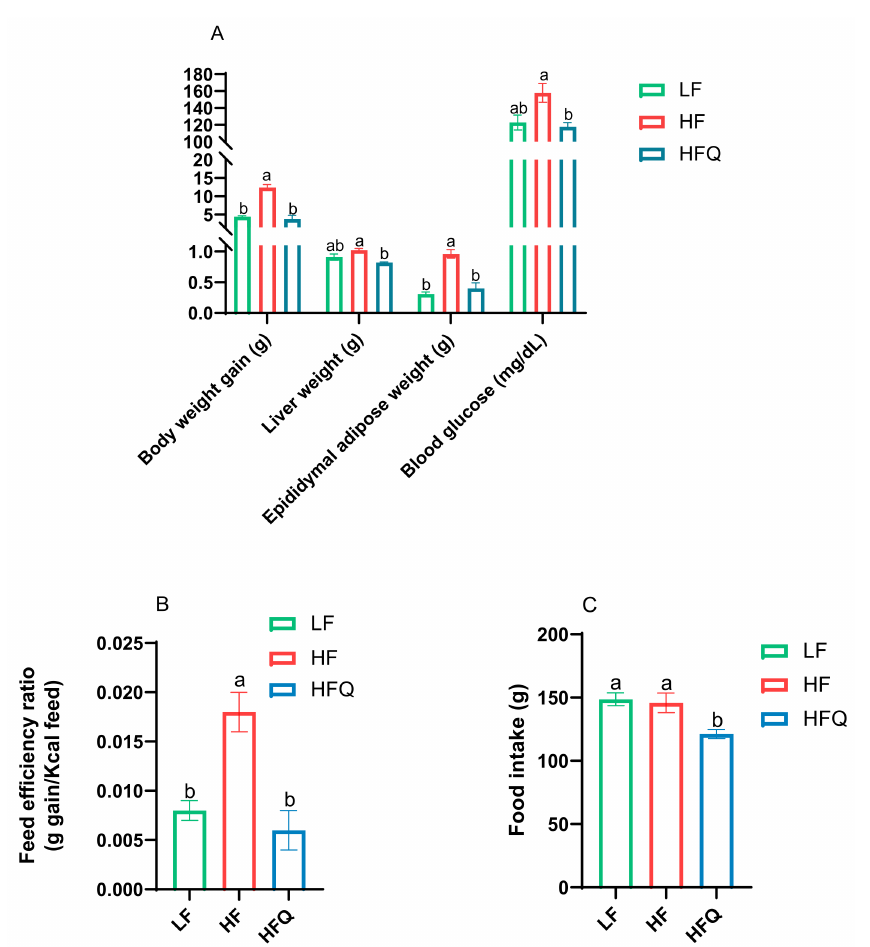
Figure 1. ( A ). Anthropometrics in mice fed HF, HFQ, and LF diets for 6 weeks. HF: high-fat control diet (46% kcal from fat, 16.5% kcal from protein, and 37.5% kcal from carbohydrate); HFQ: 0.05% quercetin in high-fat diet; LF: low-fat control diet (16% kcal from fat, 20% kcal from protein, and 64% kcal from carbohydrate) ( B ). Feed efficiency ratio of mice fed different diets. ( C ). Food intake of mice fed different diets. Values are means ± SEMs, n = 8/group. Bars with different letters were significantly different ( p <